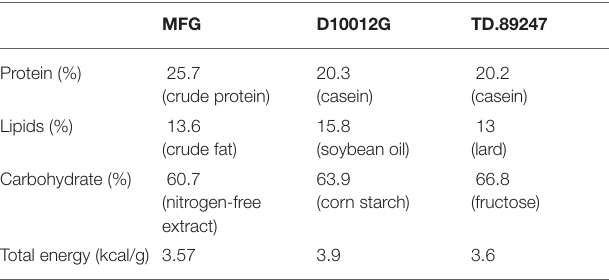
TABLE 1 | Nutritional content of the three diets